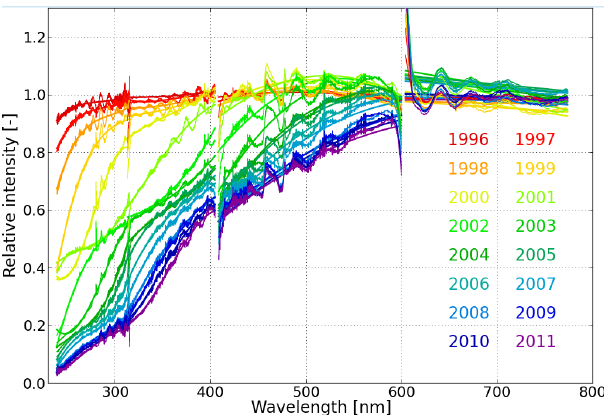
Figure 4. Relative intensity of GOME Sun mean reference spec- tra (January 1996 to 2011, one spectrum per year) with respect to a reference spectrum from 3 July 1995. Corresponding smooth solid lines denote results of the polynomial fit performed during the degradation correction. Wavelength regions around 470 and 600nm are affected by changes (outgassing) in the dichroic filter (see text for more